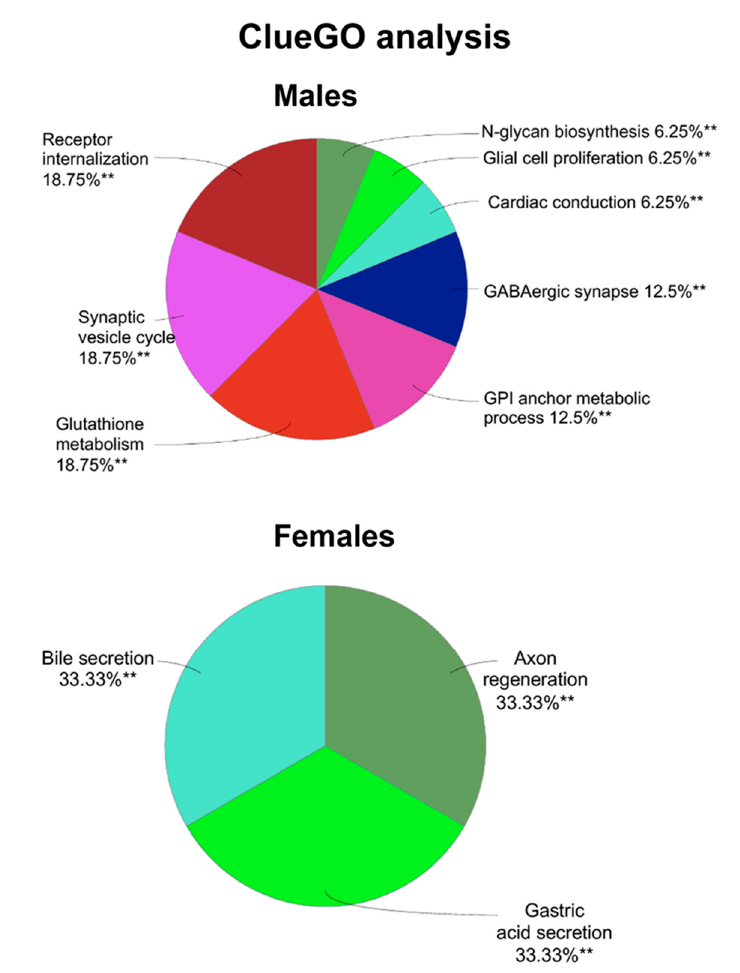
Figure 6. Mapping of biological processes. ClueGO analysis showing enriched biological processes in males and females after nicotine self-administration. The asterisks represent the group term p -value representing each category. ** p < 0.01.